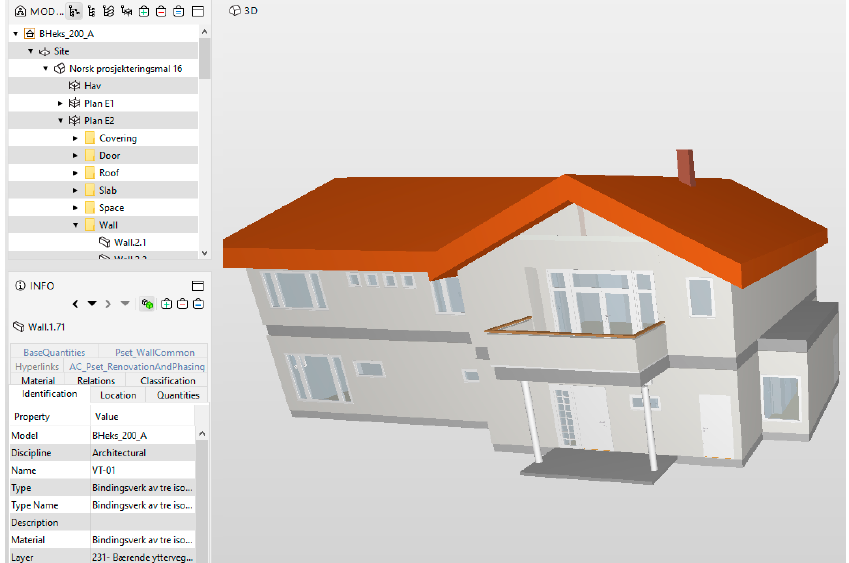
Figure 10. A single house project in Norway.